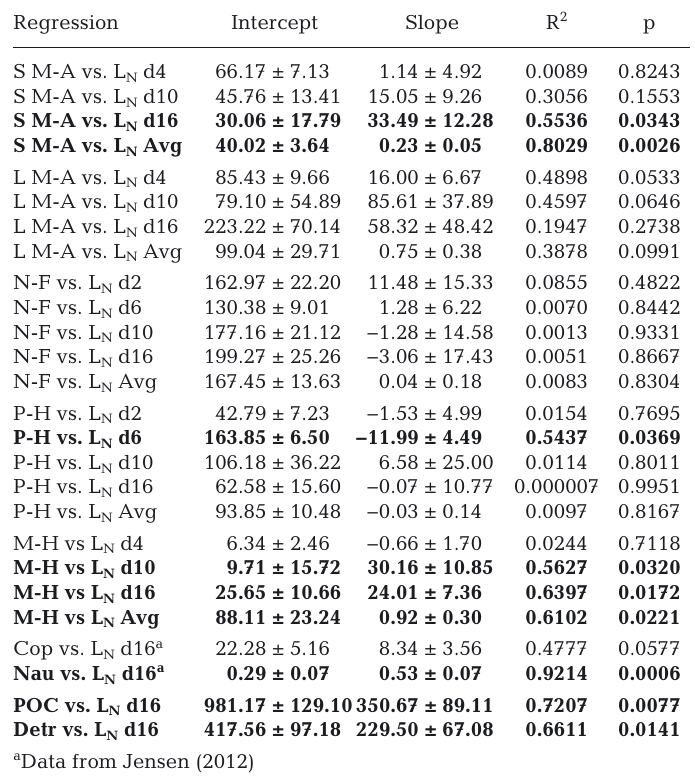
Table 3. Carbon biomass versus nitrogen loading rate ( L N ) linear regres- sions. Intercept and slope ± SE, R 2 and p-value for small and large micro- autotrophs (S M-A and L M-A), nanoflagellates (N-F), pico-heterotrophs (P-H), micro-heterotrophs (M-H), copepods (COP), copepod nauplii (Nau), particulate organic carbon (POC), and detritus (Detr). Day number (d) or averages (Avg) are given. Significant (p < 0.05) regressions are in